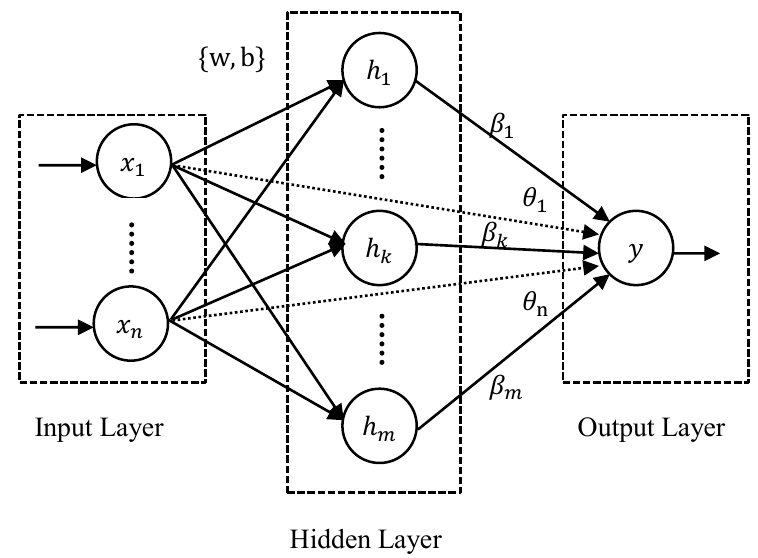
Fig.? Architecture of RVFL Figure 1. Architecture of RVFL. RVFL: Random vector functional link neural